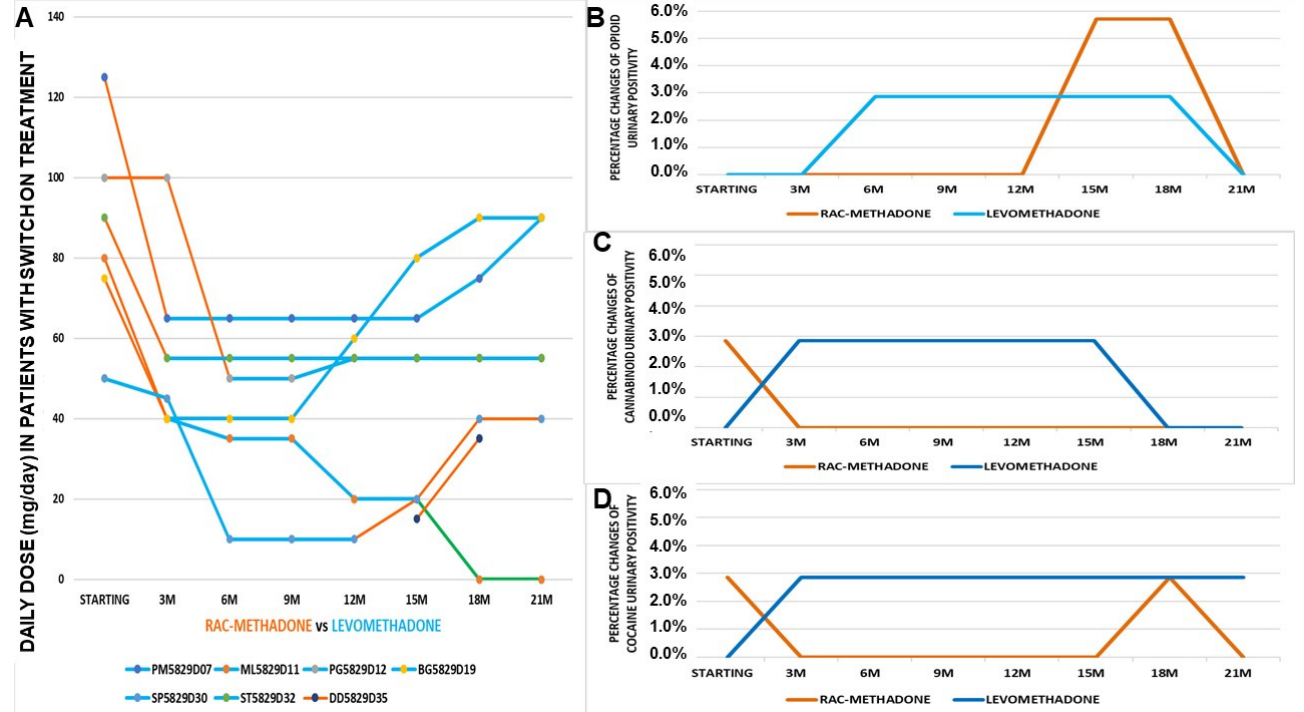
Figure 5. ( A ) Daily doses of patients with a switch of treatment over 21 months of monitoring (number of patients = 7). ( B ) Opioid positivity of patients, following a switch of treatment over 21 months of monitoring (number of patients = 2). ( C ) Cannabinoid positivity of patients, following a switch of treatment over 21 months of monitoring (number of patients = 2). ( D ) Cocaine positivity of patients with a switch of treatment over 21 months of monitoring (number of patients = 2).